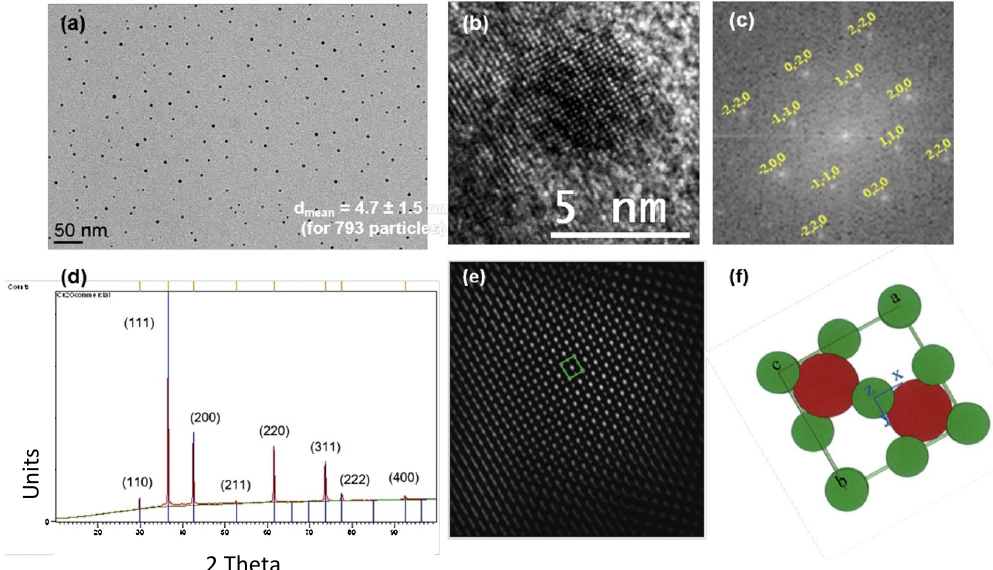
Figure 5. TEM (Ni grid) micrograph of Cu 2 O NPs in glycerol. ( a ); High Resolution-TEM micrograph of one isolated particle dispersed in glycerol ( b ) HR-TEM micrograph (Ni grid) of one isolated particle of Cu2ONP- 20 dispersed in glycerol after centrifugation; ( c ) electronic diffraction spots observed by fast Fourier transform of one ingle particle (image b ); ( d ) powder X-ray diffraction analysis of Cu 2 ONPs at solid state ( e ); image with filters showing the zone axis [001] ( f ); with the corresponding drawing of the cubic structure of bulk Cu 2 O. Reproduced with permission from [16], published by John Wiley and Sons, 2014.